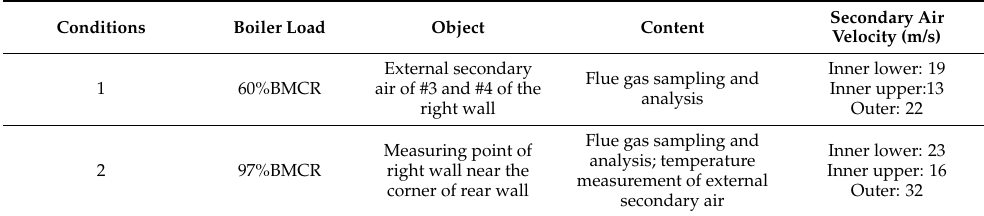
Table 1. Working conditions of secondary air